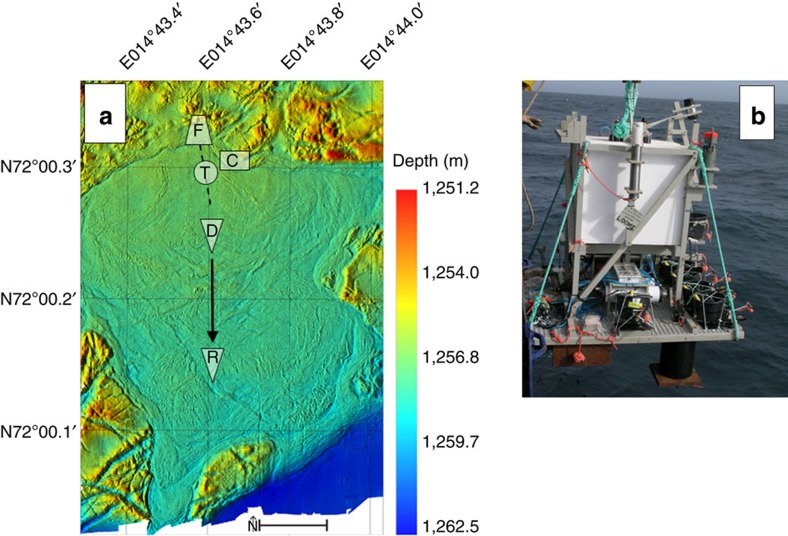
Overview of the deployment area and instruments.(a) Shaded relief map of the central area of the Håkon Mosby mud volcano. The LOOME observatory frame (F) was positioned north of the centre, where the hummocky seafloor provided a solid base for our long-term instrument deployment. The seabed thermistor chain (dashed line) with 24 sensor nodes was laid out across the northern part of the active centre. The short temperature lance and the chemistry logger (T) were placed at the position of the highest geothermal gradient. The camera (C) was placed on the edge of the central area in a field of abundant microbial mats. The long temperature lance was deployed south of the centre in July 2009 (D) but had moved 165 m further to the south by the time it was recovered in September 2010 (R). Scale bar, 100 m. (b) The LOOME observatory frame before deployment. The black buckets contained the cables by which the sensors were connected to data loggers mounted on the frame.